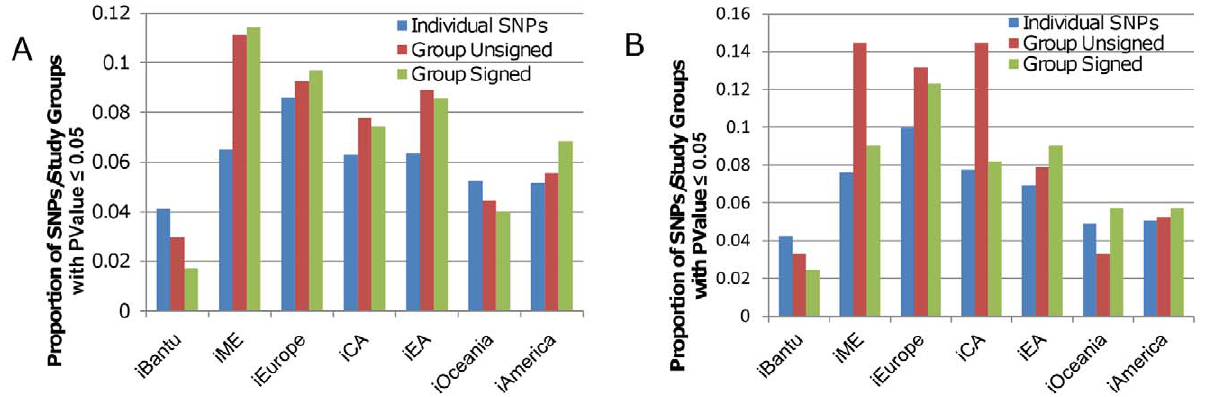
Figure 2. Proportion of SNPs and study groups with P-values # 0.05 for iHS scores. A) The blue bars represent the proportion of individual GWAS SNPs in the analysis of all 1,336 GWAS SNPs that had a p-value of 0.05 or less for each iHS score. The red bars represent the proportion of study groups in the unsigned group analysis with a p-value of 0.05 or less for each iHS score. The green bars represent the proportion of study groups in the signed group analysis with a p-value of 0.05 or less for each iHS score. B) The same as in A) except that the blue, red, and green bars represent the II individual SNP, group unsigned, and group signed analyses, respectively.